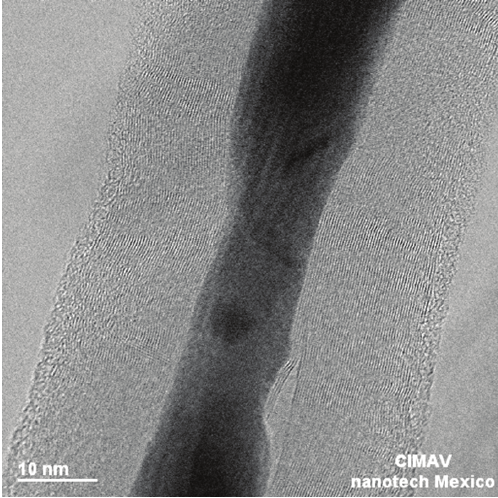
Figure 10: TEM images of carbon nanotubes of first isothermal zone synthesized to 900 ◦